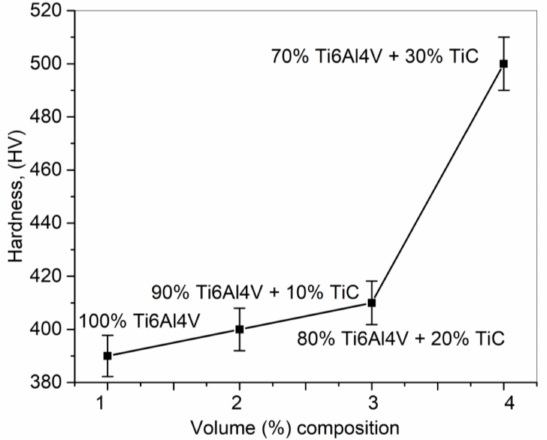
Figure 15. Effect of vol.% of TiC on hardness; based on the data from